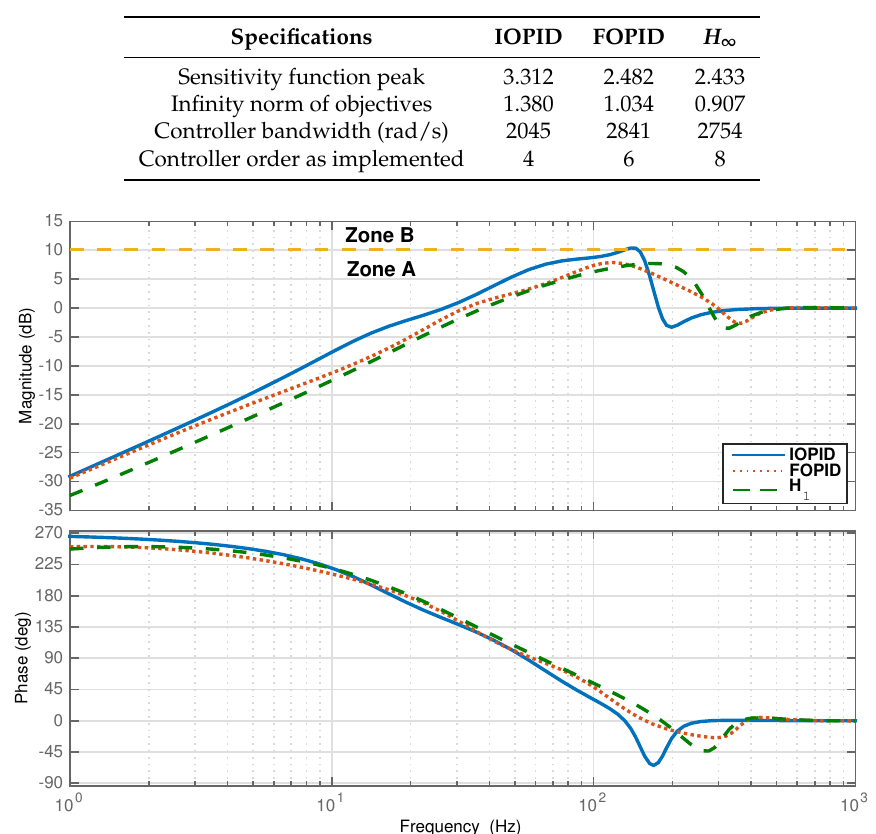
Figure 30. Bode plots of the thrust AMB sensitivity and complementary sensitivity